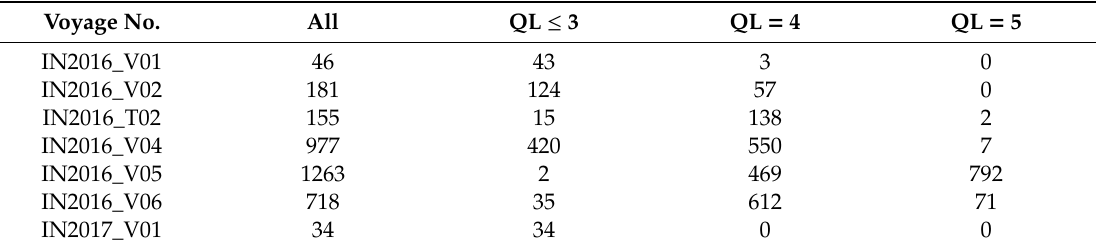
Table 3. Number of matchups for di ff erent ISAR quality levels (QLs).